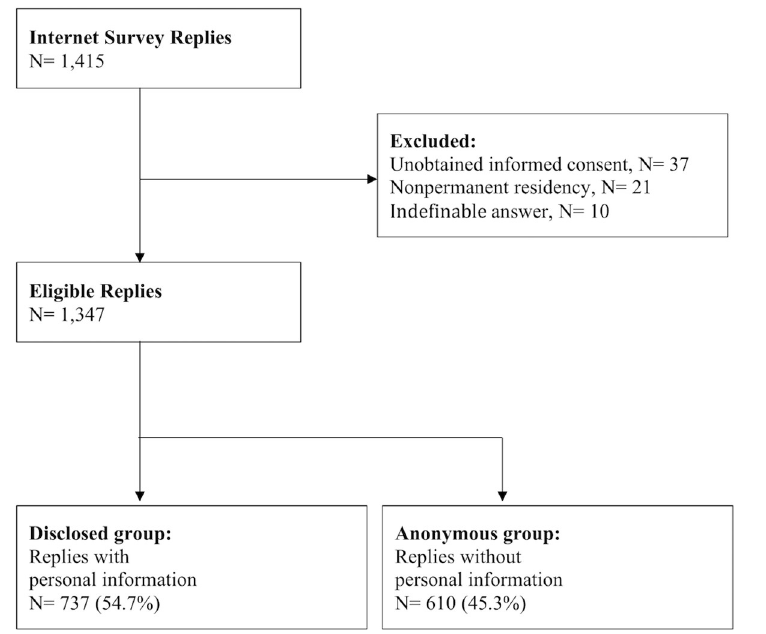
Fig 1. Flowchart of data